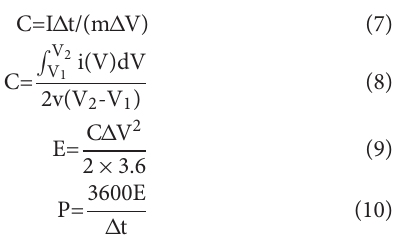
Frontiers in Energy Research |